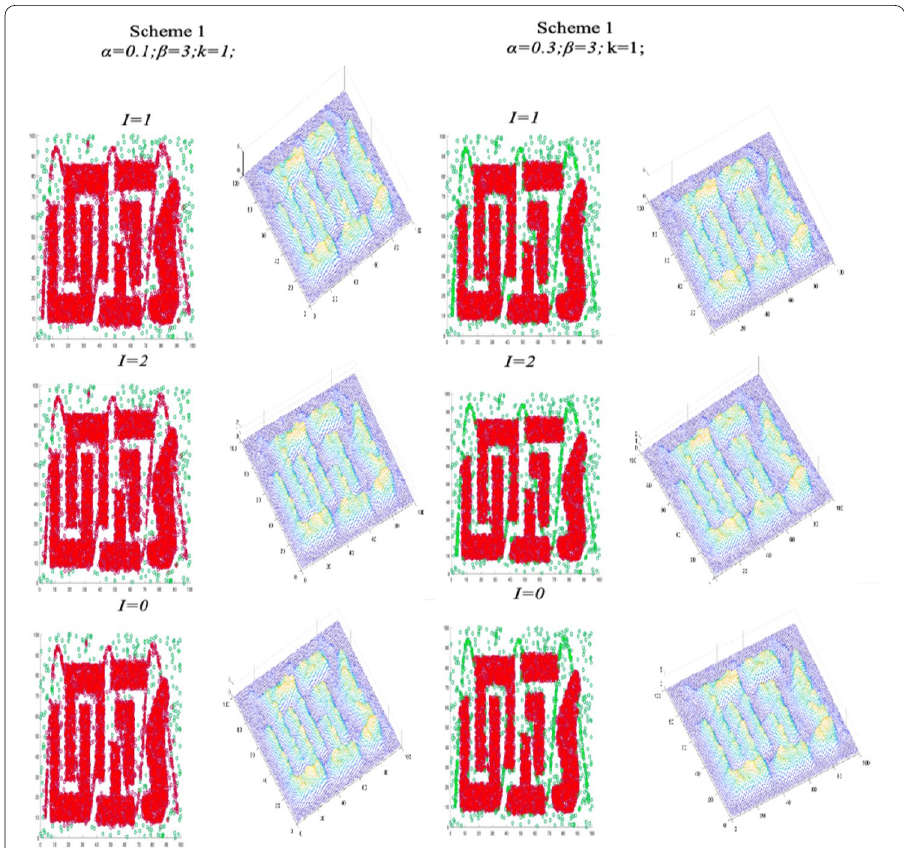
Fig. 8 Outlier Detection results using scheme 1 with two different values of α shown in green and the inlier data in